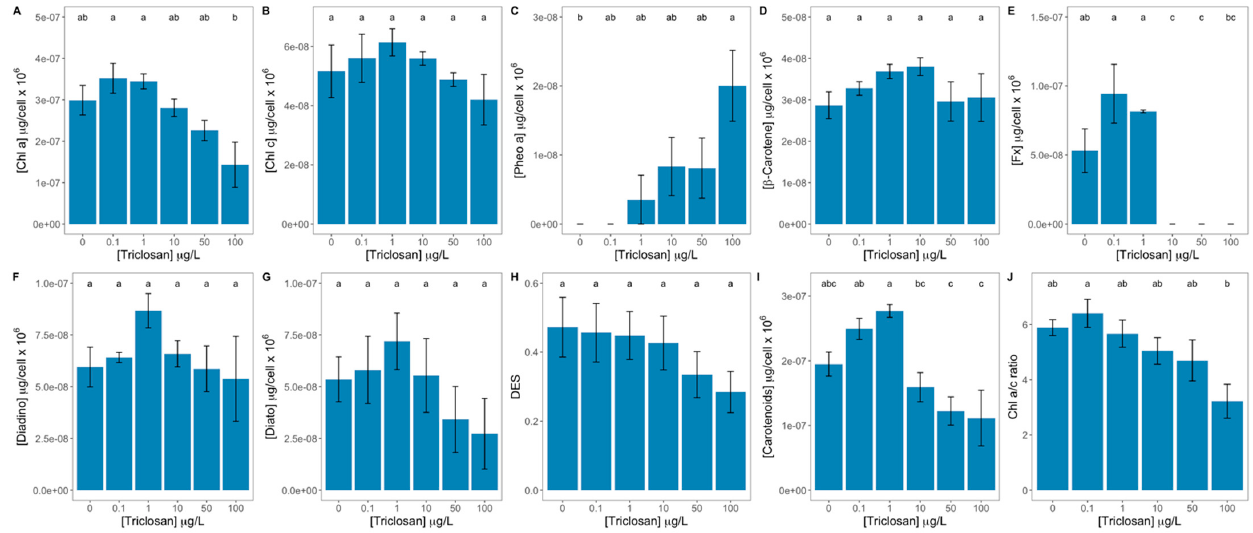
Figure 5. Triclosan-exposed Phaeodactylum tricornutum cultures pigment concentrations [chlorophyll a (Chl a, A ), chlorophyll c (Chl c , B ), pheophytin a (Pheo a , C ), β -carotene ( D ), fucoxanthin (Fx, E ), diadinoxanthin (Diadino, F ), diatoxanthin (Diato, G )], de-epoxidation index (DES, H ), total carotenoid concentration ( I ), and chlorophyll a to c ratio ( J ) (average ± standard error, n = 3; different letters denote significant differences between triclosan treatments at p <